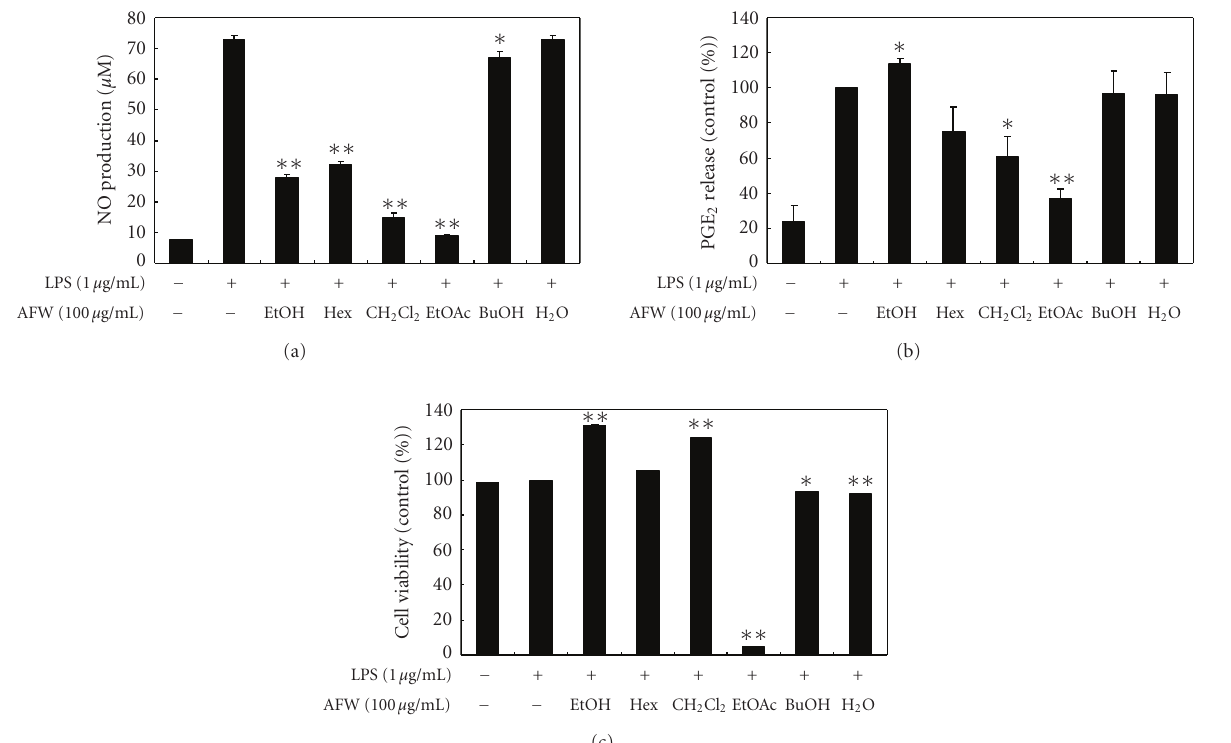
Figure 2: E ff ect of crude extract and solvent fractions from A. koreanum fruit waste on nitric oxide (a) and PGE 2 (b) production in RAW 264.7 cells. E ff ects of crude extract and solvent fractions from A. koreanum fruit waste on the nitric oxide production in RAW 264.7 cells were determined from the 24-hr culture of cells stimulated with LPS (1 μ g/mL) in the presence of A. koreanum . Nitric oxide production was determined by the Griess reagent method. PGE 2 released into the culture medium was assayed by ELISA. The data represent the mean ± SD of triplicate experiments. Values are the mean ± SEM of triplicate experiments. ∗ P < . 05; ∗∗ P < .